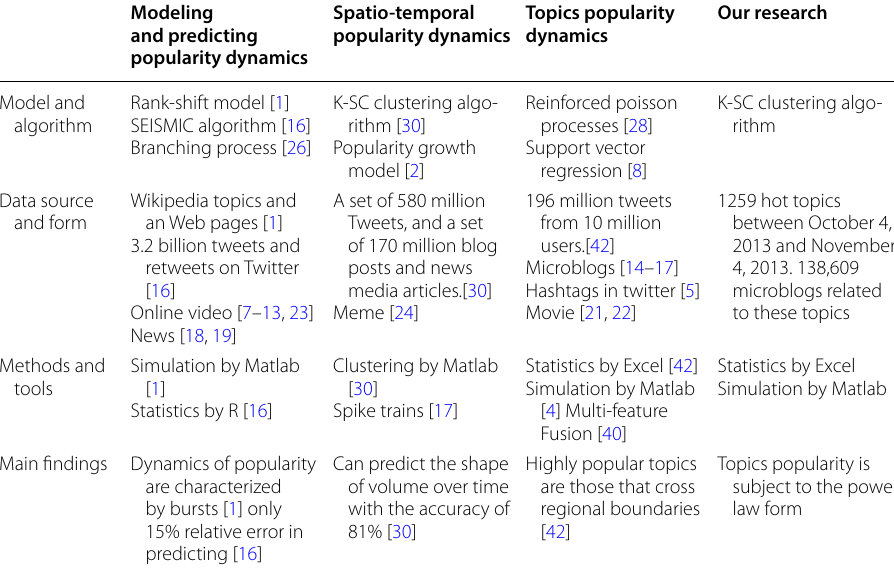
Table 1 Comparisons between previous research and our research